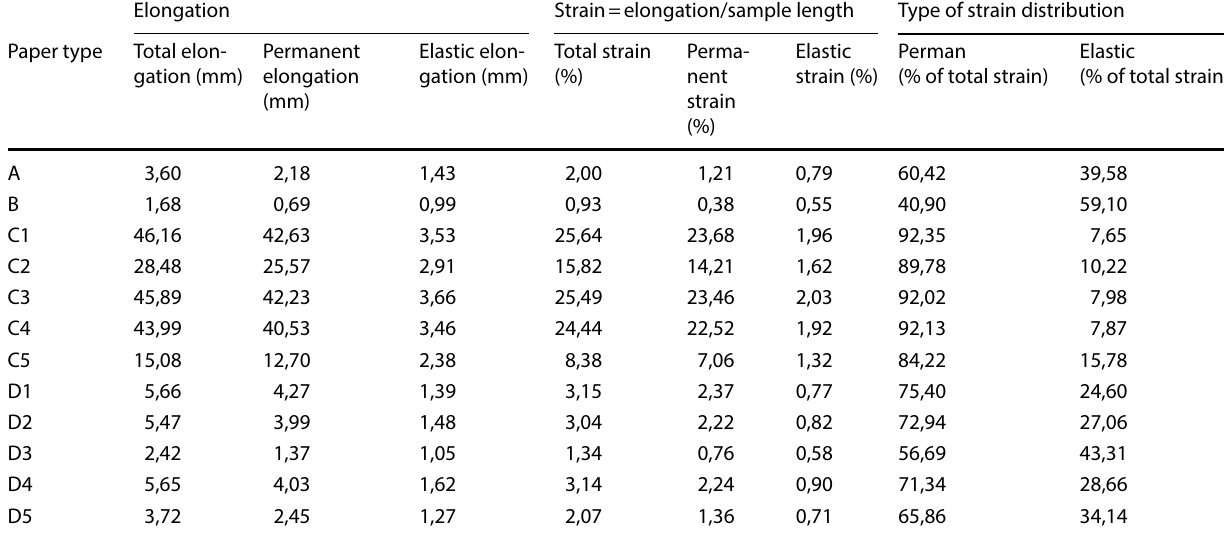
Table 3 Averaged results of elastic contraction tests following a force of 30 N Elongation Strain = elongation/sample length Type of strain